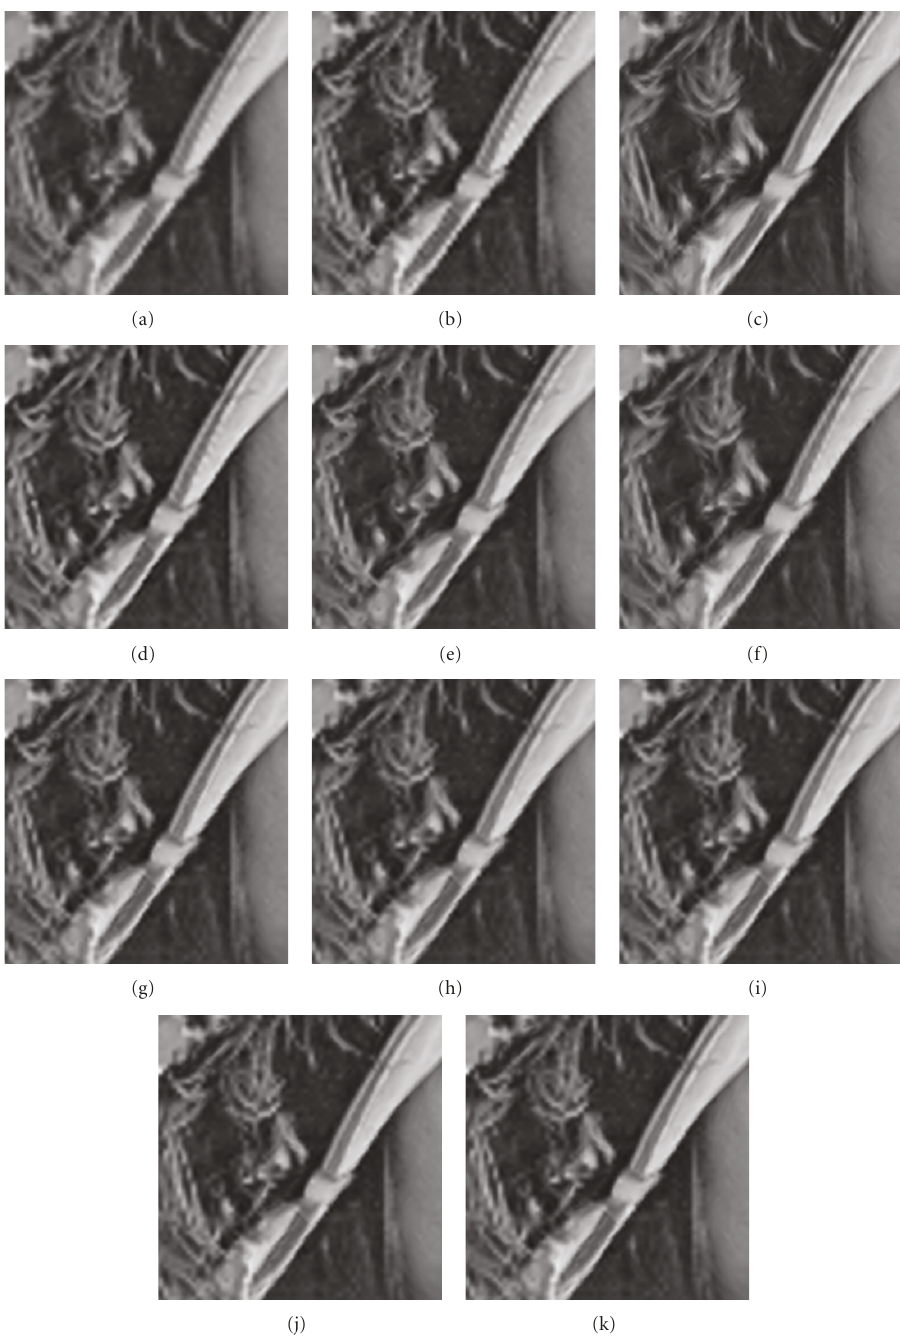
Figure 11: Portions of resolution enhanced “Lena” image by (a) bilinear; (b) bicubic; (c) edge-directed method ( M = 8) [12]; (d) ICBI [20]; (e) LMMSE-based method ( ζ = 1, ξ = 1 . 5) [17]; (f) SAI ( λ = 0 . 5) [18]; (g) NN-based method [16]; the proposed method utilized (h) bilinear kernel and (i) bicubic kernel without edge enhancement; (j) bilinear kernel and (k) bicubic kernel with edge enhancement.